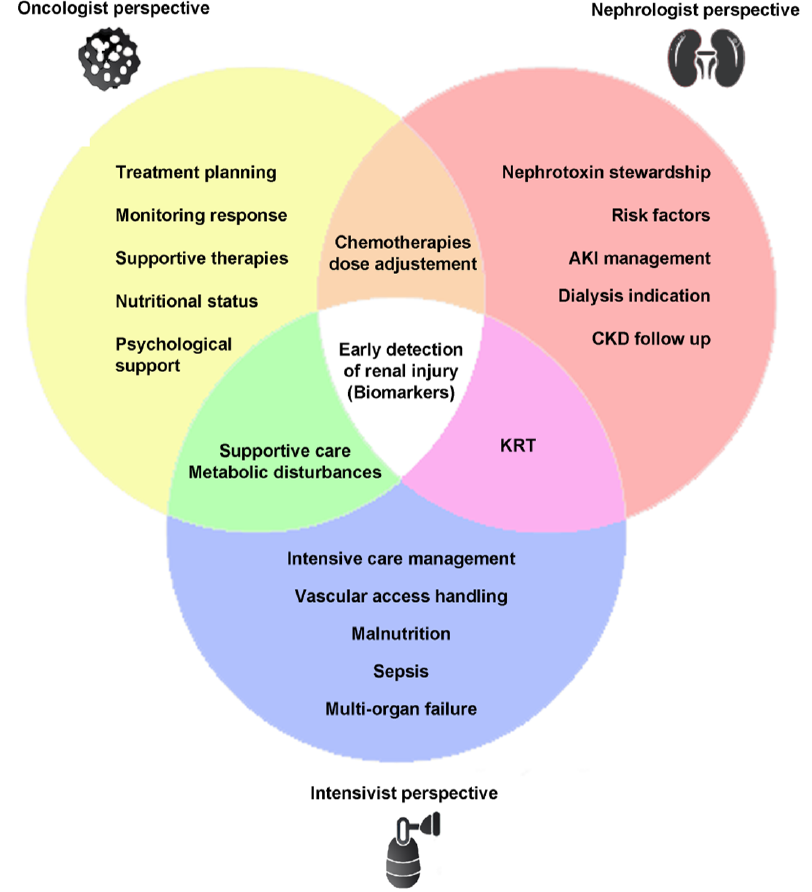
Figure 4. The ideal management of cancer patients with nephrotoxic-AKI. Venn diagram representing the aspects to be considered when treating patients for early acute kidney injury (AKI) recognition and effective oncologic patient management. Abbreviations: KRT: Kidney Replacement Therapy; CKD: Chronic Kidney Disease.